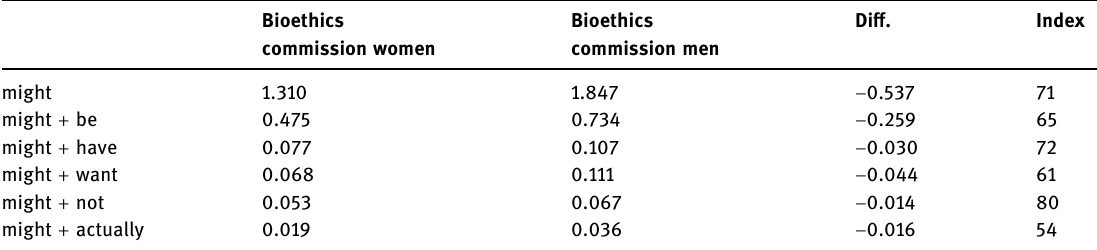
Table 27: Most frequent collocation with “ might, ” as per cent of total tokens ( normalised, n = 1,000 )